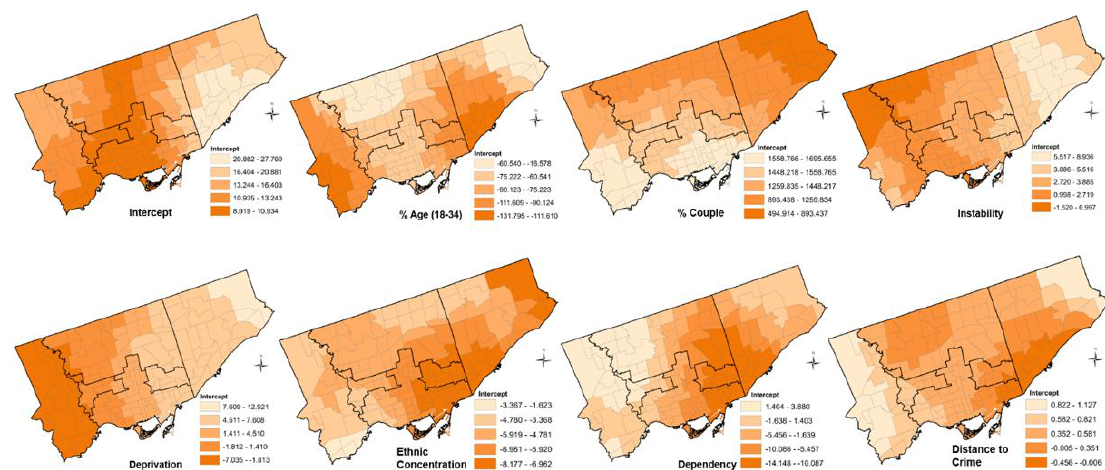
Figure 5. GWR local coefficients for intercept and independent